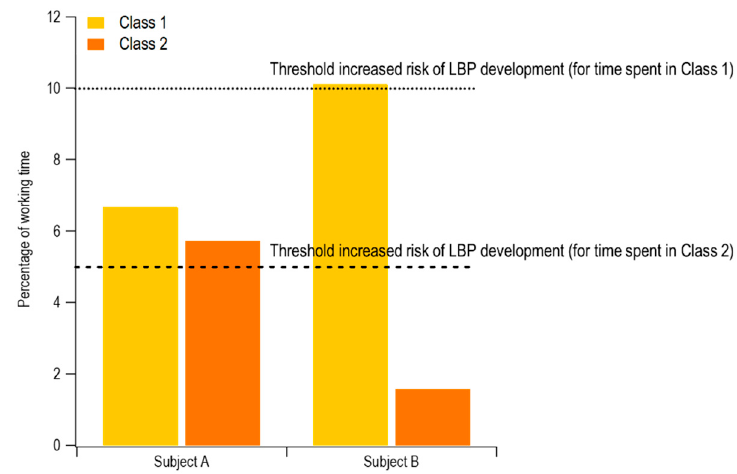
Figure 4. Example of different postural behaviors adopted by two participants performing the same kind of activities. Noted thresholds for low back pain (LBP) are from [38].